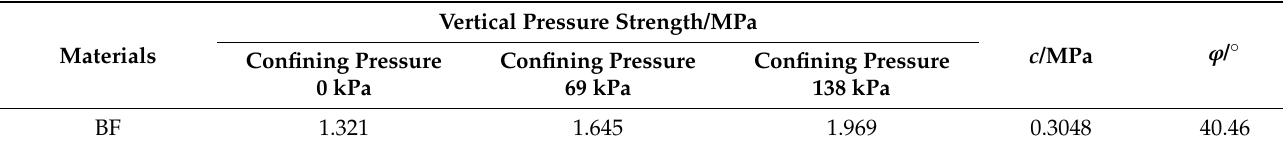
Table 2. Shear parameters of basalt fiber asphalt mixture.